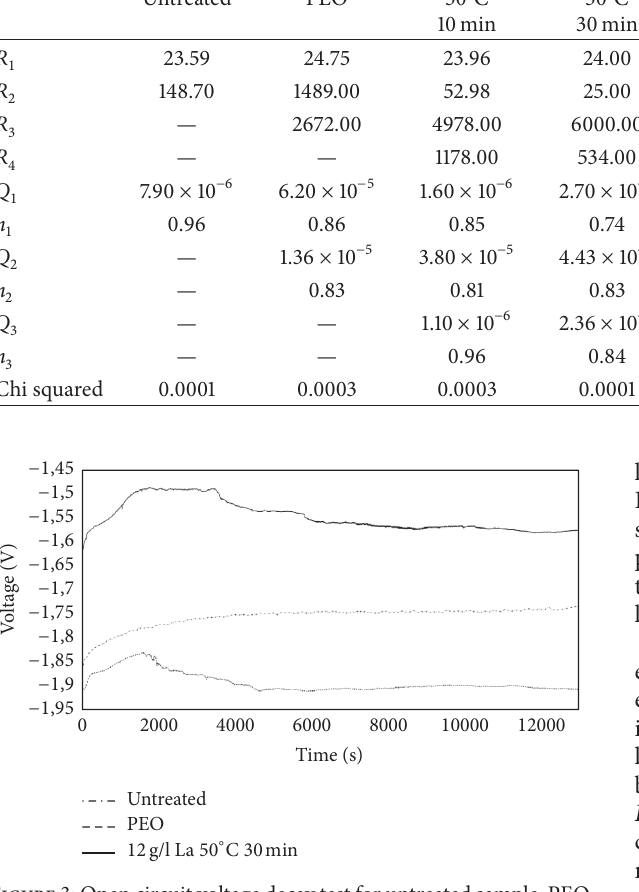
Figure 3: Open circuit voltage decay test for untreated sample, PEO coated sample, and best performance sealed